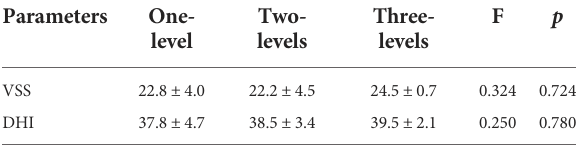
TABLE 2 Preoperative VSS and DHI scores in patients with different numbers of instability segments (x±, n